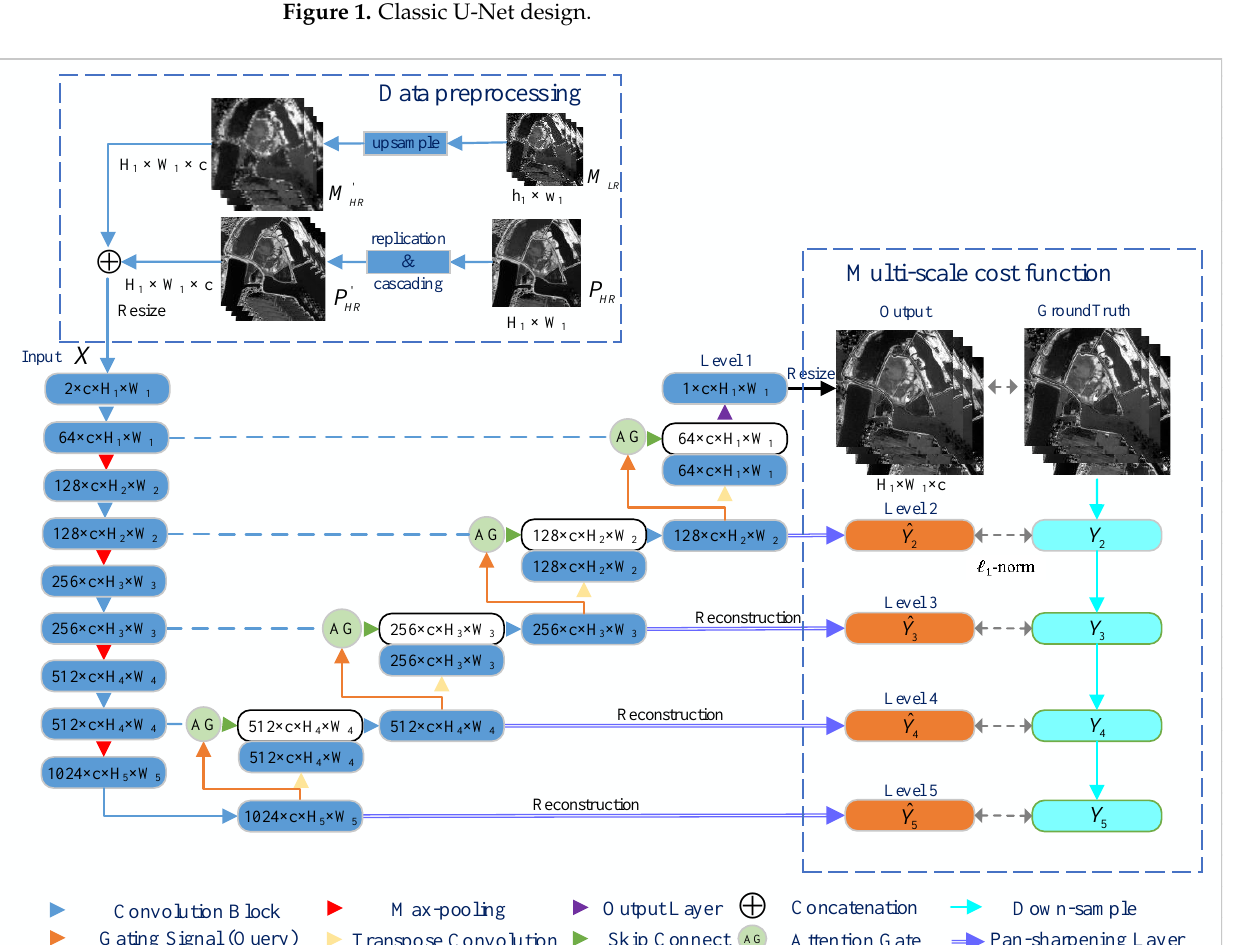
Figure 2. The proposed MSAC-Net